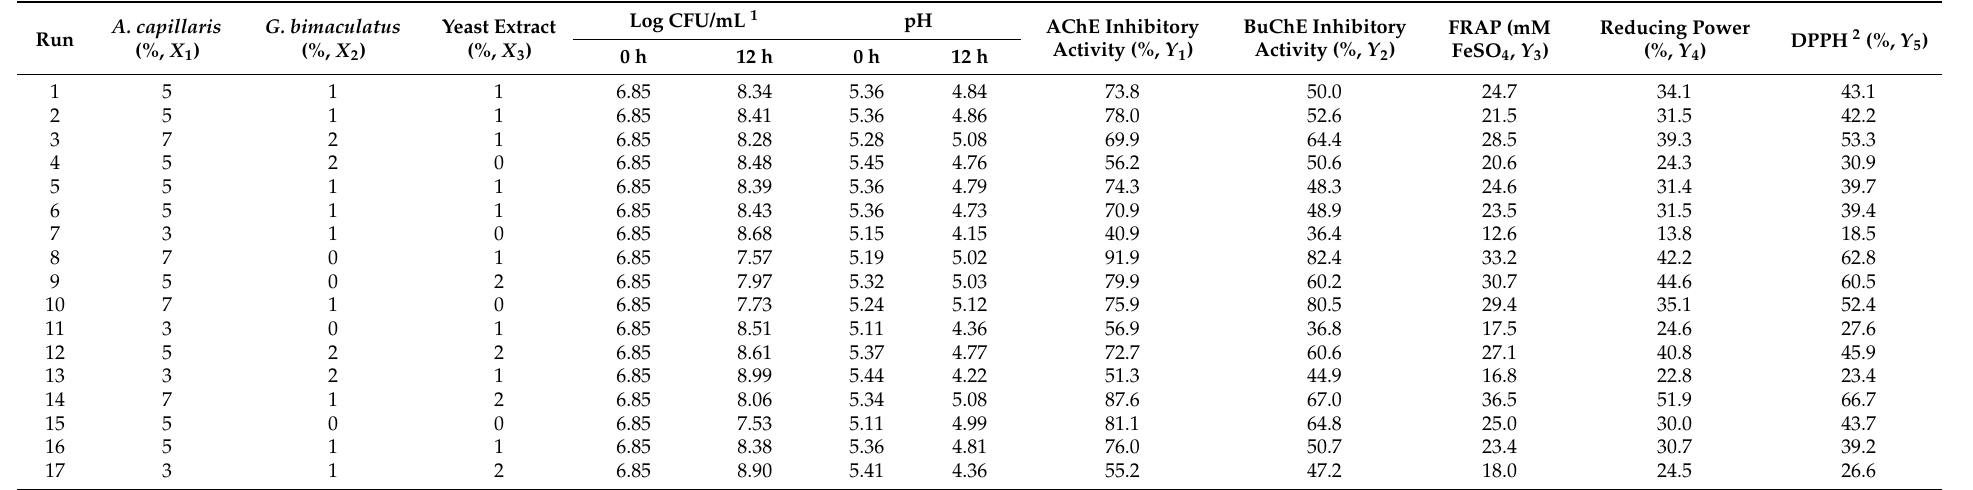
Table 2. Change of the viable cell counts, pH value, and physiological activities of MKJW fermented A. capillaris